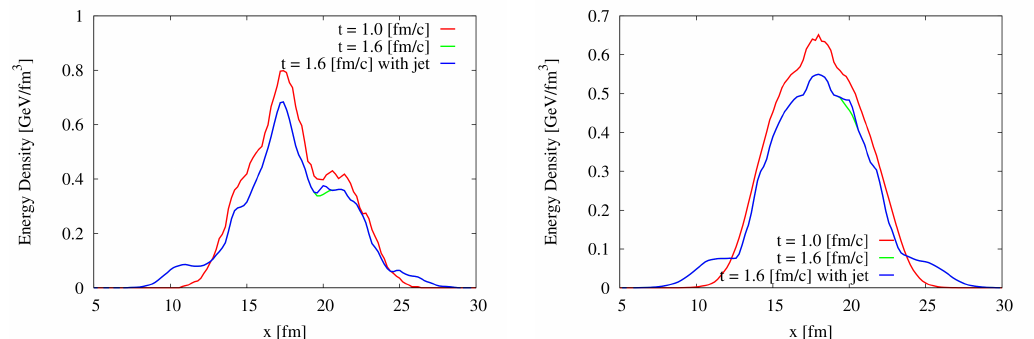
Figure 2. Energy density projection in 1D ( y = z = 0) of Pb+Pb at 2.76 TeV. UrQMD initial conditions - red line. Hydrodynamic simulations with jet - blue lines, without jet - green lines. Initial condition from UrQMD averaging over 10 events ( left panel ) and 500 events ( right panel